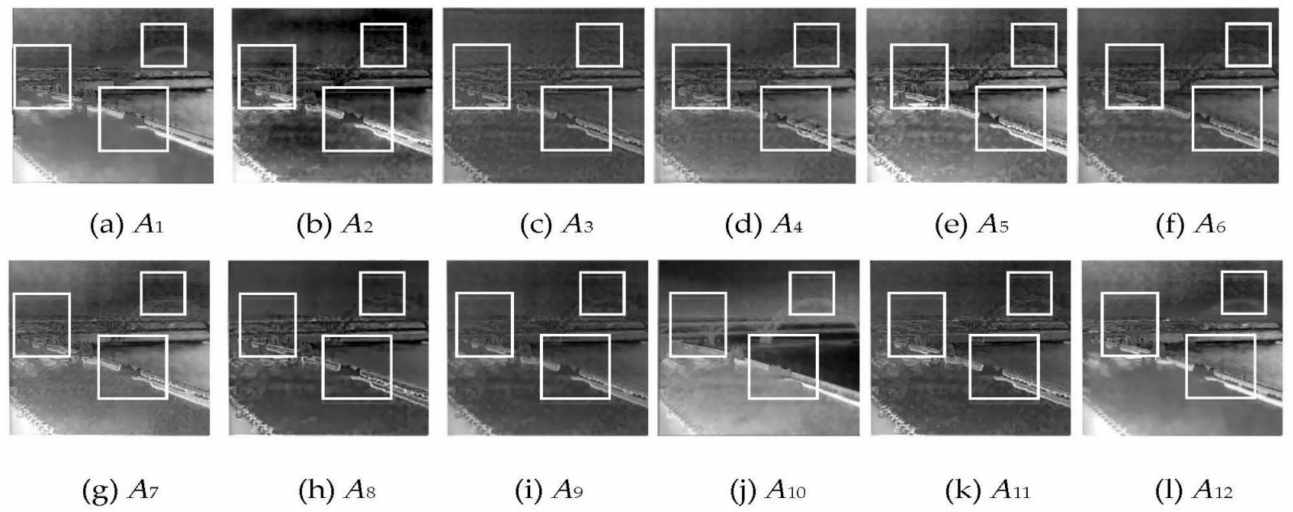
Figure 10. Fusion results of the first group of images using different methods.